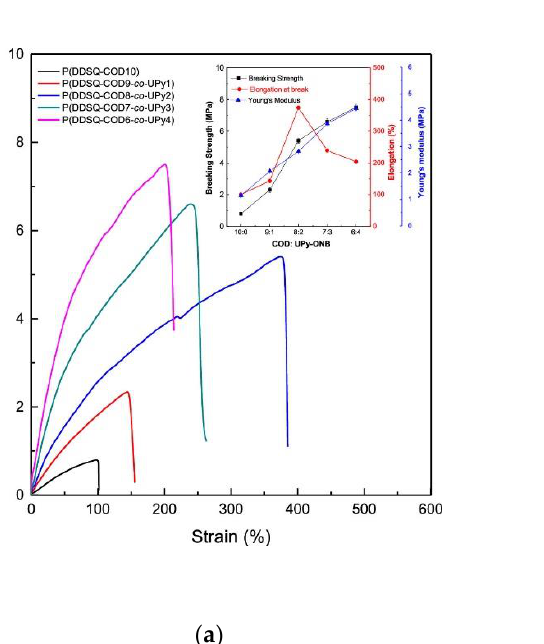
Figure 7. ( a ) Stress – strain curves of P(DDSQ-COD-co-UPy)s; ( b ) Stress – strain curves as functions of self-healing time. Reprinted with permission from Macromolecules 2020 , 53 , 7119−7131. [70] Copy- right (2020) American Chemical Society.